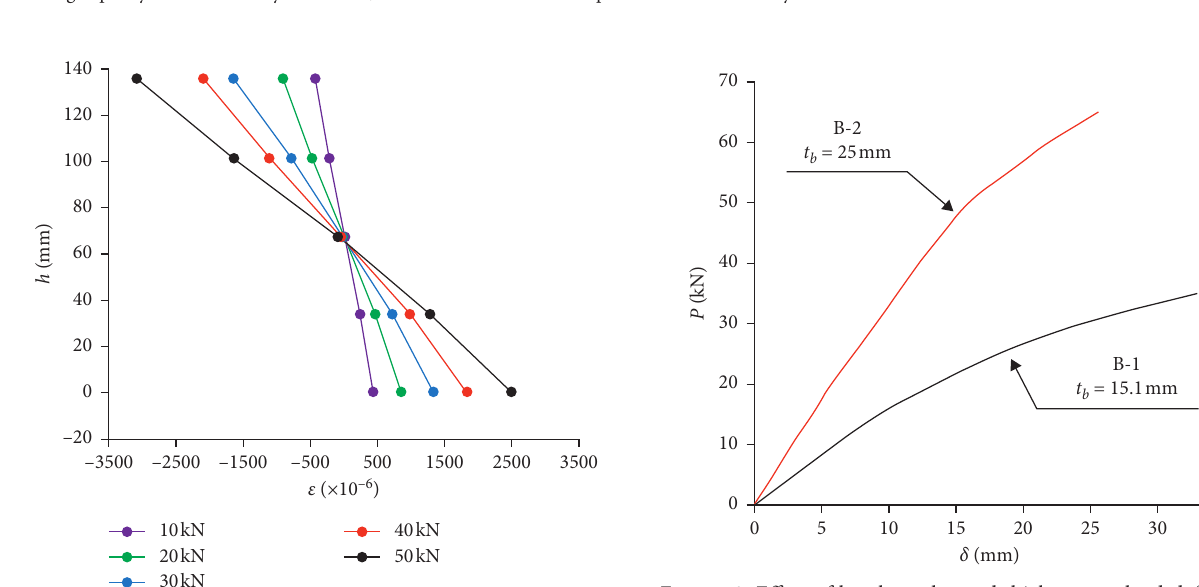
Figure 8: Effect of bamboo plywood thickness on load-deflection